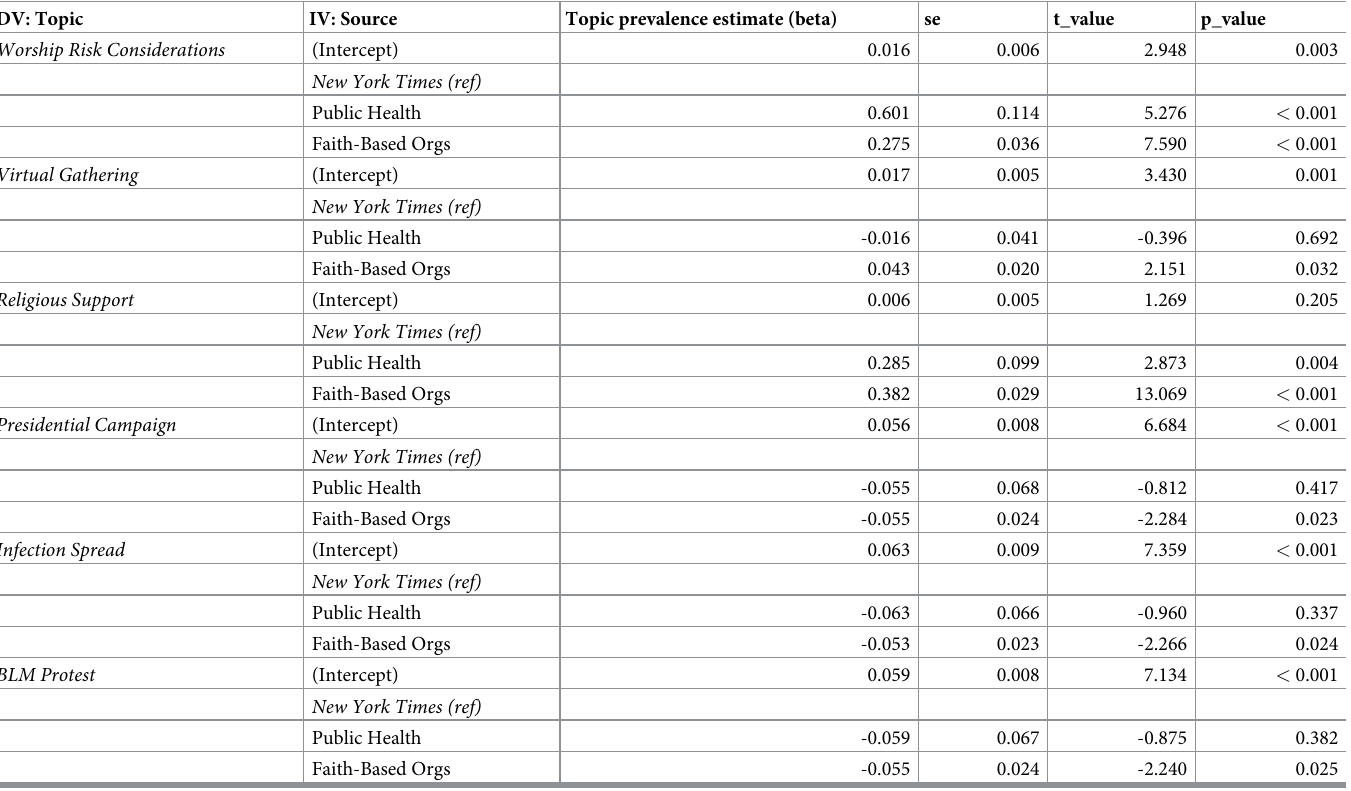
Table 3. Structural topic modeling regression